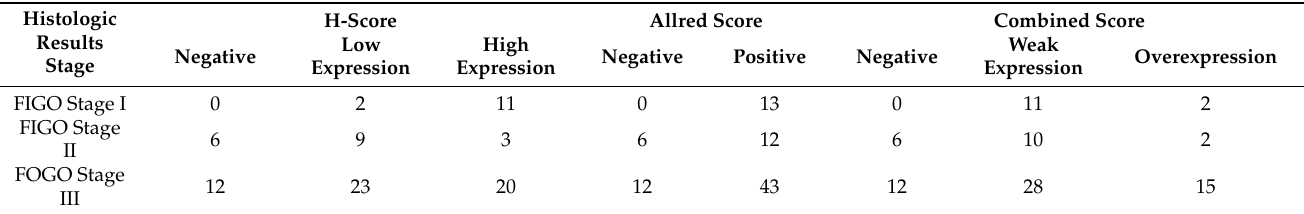
Table 3. Distribution of patients according to FIGO stage and the final immunohistochemical